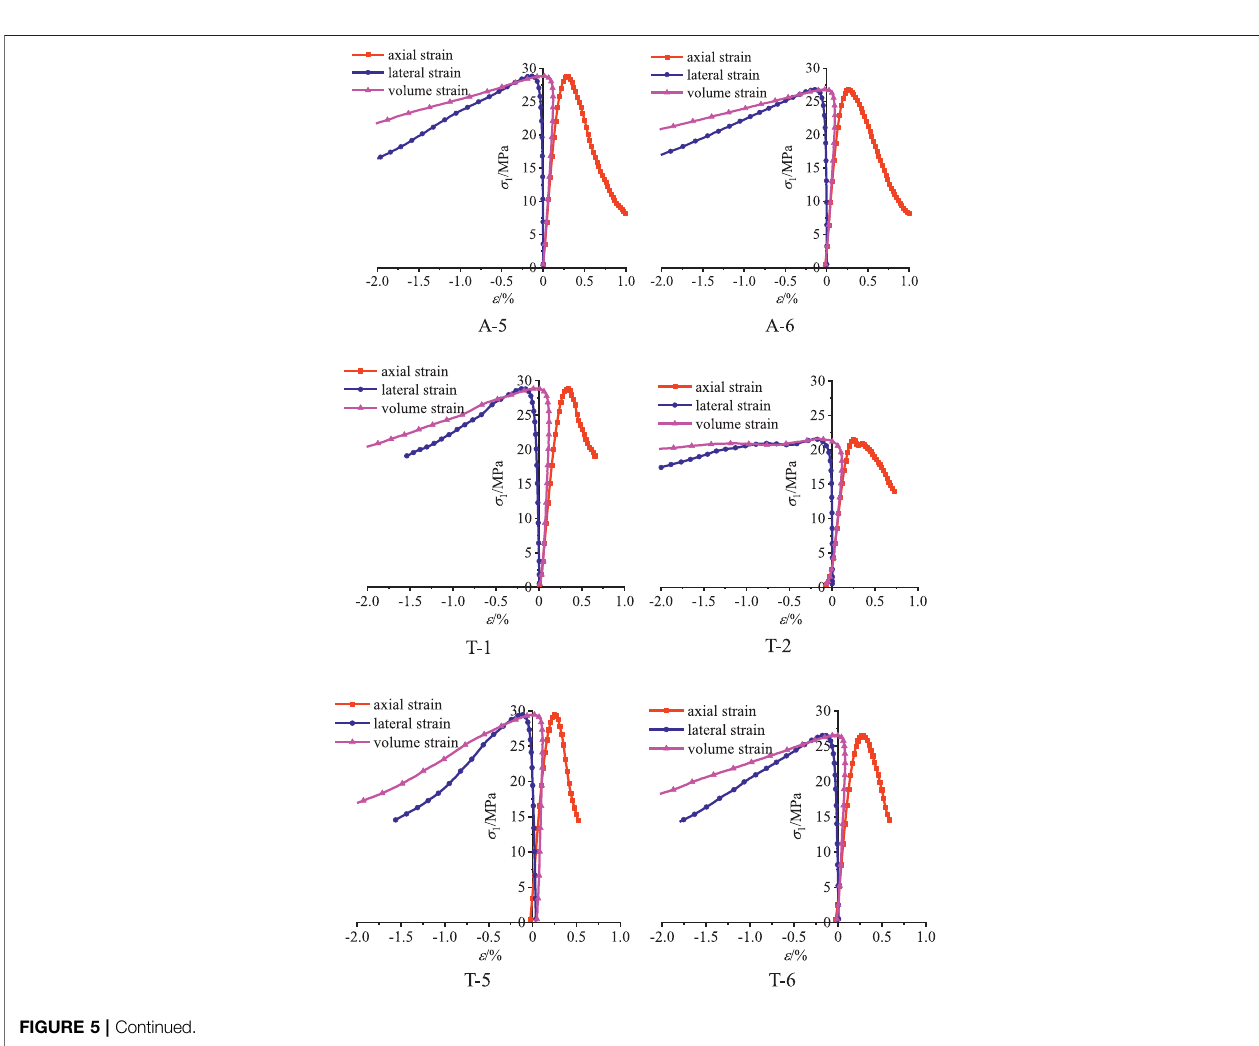
Figure 6 . It can be seen that the axial stress-strain curve and volumetric strain curve of saturated concrete are divided into fi ve stages: crack closure (Stage I), elastic behavior (Stage II), stable crack growth (Stage III), unstable crack growth (Stage IV), and failure (Stage V). In Stage I, the crack volumetric strain is positive, and the slope of the curve is positive, which indicates the initial cracks, pores, etc. inside the sample are closed under axial stress, resulting in reduction in the volume of the crack and the